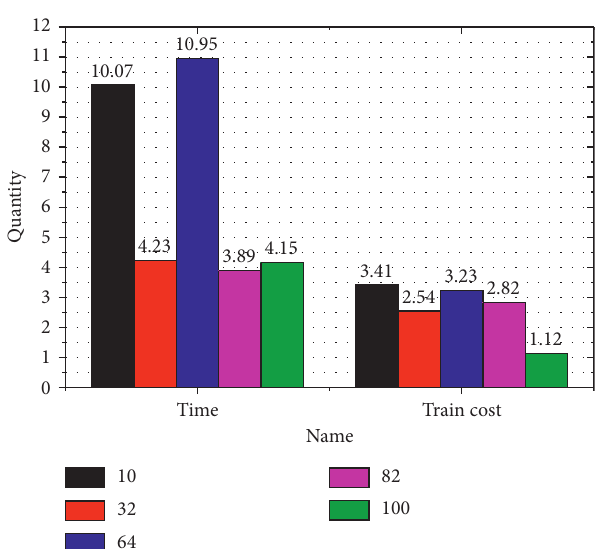
Figure 2: Training loss and time required for MRDL_4 model with different number of neurons in the hidden